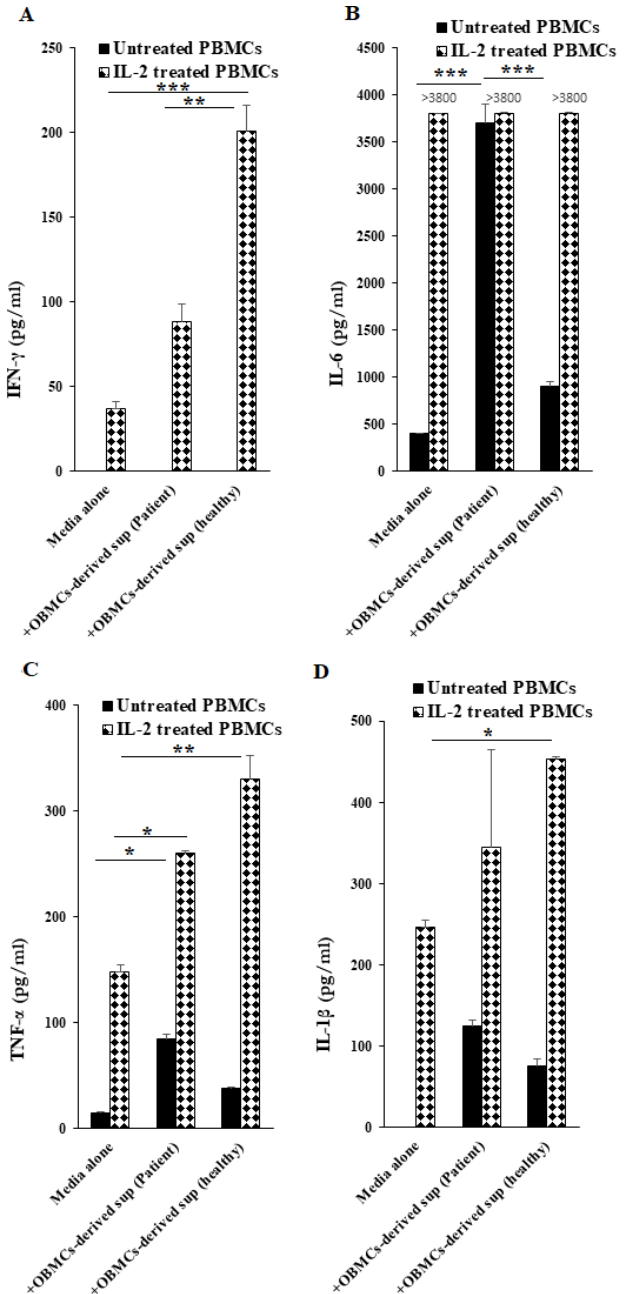
Figure 4. Periodontitis patients’ OBMCs-derived supernatant had decreased ability to activate allogeneic healthy PBMCs in comparison to healthy individuals’ OBMC-derived supernatant. Untreated OBMCs (1 × 10 6 /mL) of healthy individuals and periodontitis patients were incubated at 37 ◦ C for 6–12 h before supernatants were harvested. Allogeneic healthy PBMCs (1 × 10 6 /mL) were left untreated or treated with IL-2 (500 U/mL) for 12–18 h, after which, OBMCs-derived supernatants were added to PBMCs, and 18–20 h later the supernatants were harvested to determine IFN- γ ( A ), is shown in this figure. *** ( p value < 0.001), ** ( p value 0.001–0.01), * ( p value